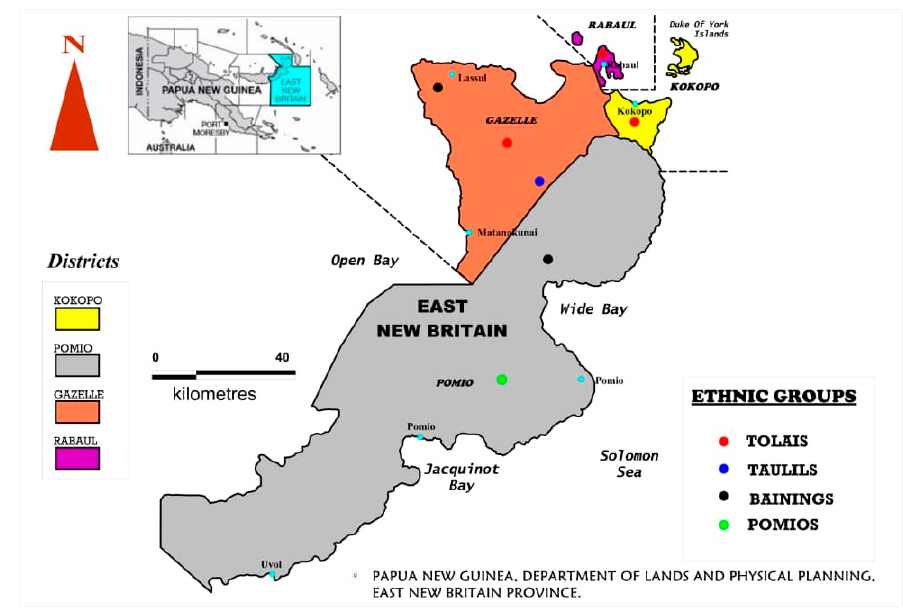
Figure 1. Map of East New Britain Province, Papua New Guinea; Map drawn by and with permission from; Ashley Lais (2020). Lands Department, East New Britain Province, Papua New Guinea.